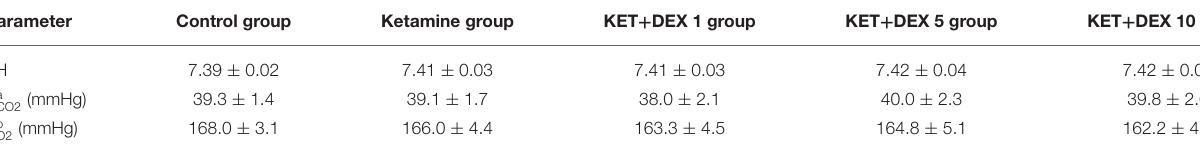
TABLE 3 | The arterial blood gases analyse. Parameter